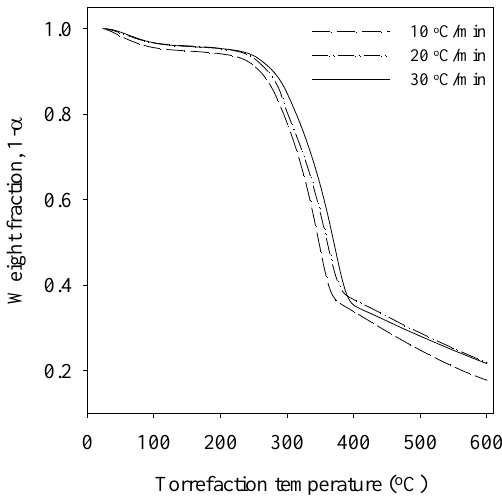
Figure 2. TGA analysis of waste wood with respect to torrefaction temperature.